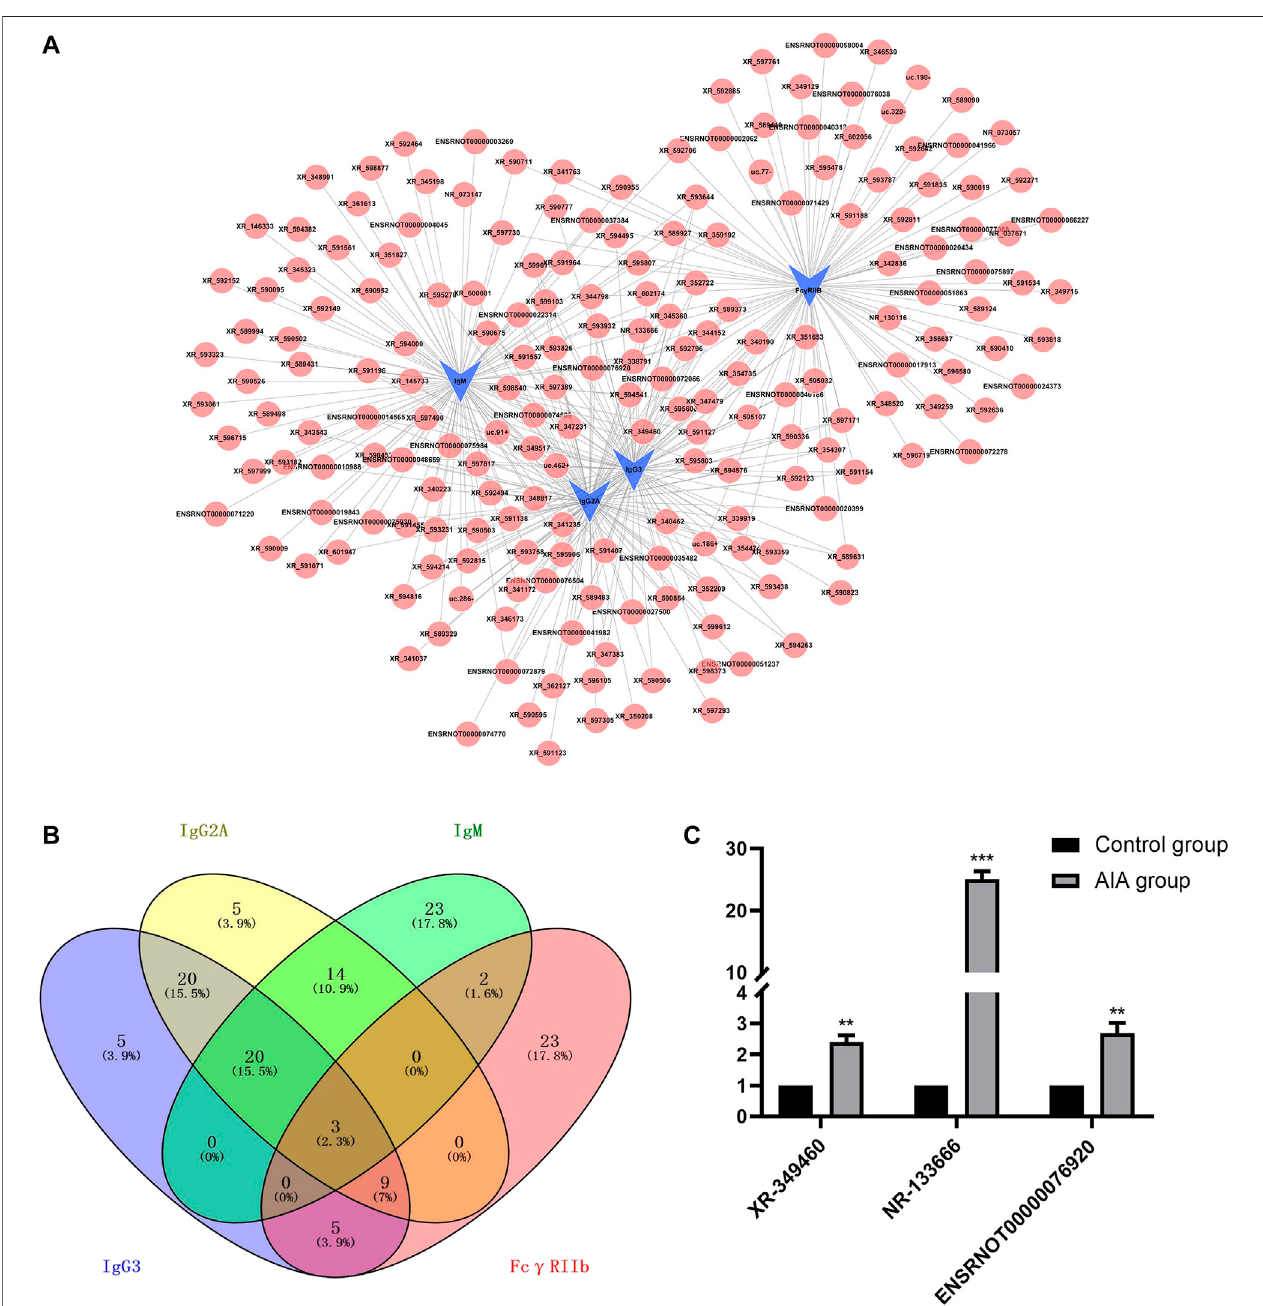
FIGURE 2 | lncRNA-mRNA co-expression networks and real-time quantitative PCR validation. (A) Four veri fi ed co-expression networks of mRNAs and their associatedlncRNAs.ThebluedotsrepresentmRNAsandreddotsrepresenttheircorrelatedlncRNAs.Therewere309positiveinteractions(linkedwithcontinuouslines) and 66 negative interactions (linked with dotted lines). The absolute value of correlation coef fi cients of all the directly linked pairs exceeded 0.990. (B) Venn diagram illustrating the intersections of lncRNAs with Pearson correlation coef fi cients equal to or higher than 0.992, using 4-way Venn Diagram Generator. The common intersection result is upregulated lncRNA XR-349460, NR-133666 and ENSRNOT00000076920. (C) The qRT-PCR validation of the three selected lncRNA. Results were similar to that of lncRNA microarray.